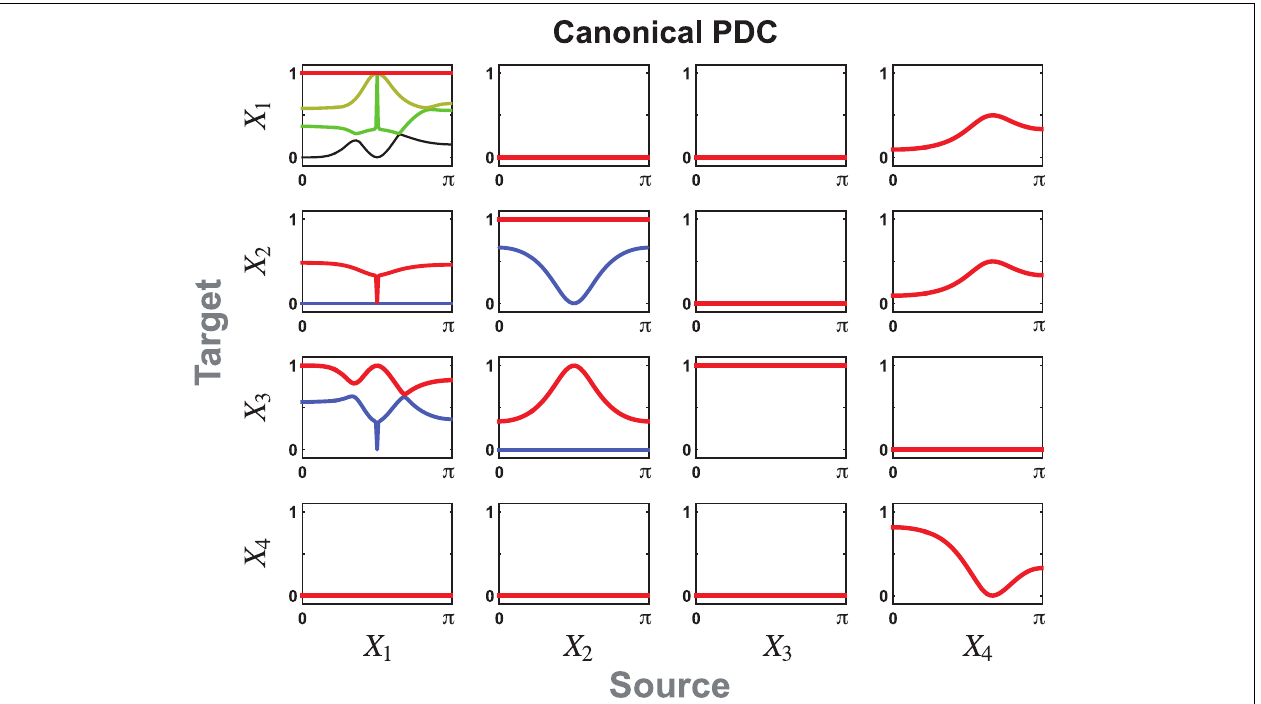
FIGURE 4 | The cPDC for Example 2 reflects the existence of the notch connecting filters from X 1 to X 2 and to X 3 . The intrinsic dynamics of the oscillators from a subregion of X 1 into X 3 is apparent in the resonances of the largest cPDC component. The resonance within block X 2 manifest itself in the single non-zero component into